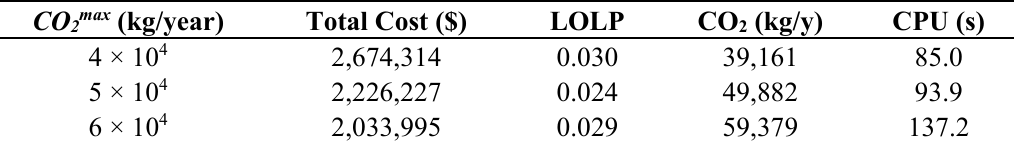
Figure 5. Numbers of WTG, PV, ES, and diesel generators considering different CO 2max . Table 7. Result comparison between different CO 2 constraints.